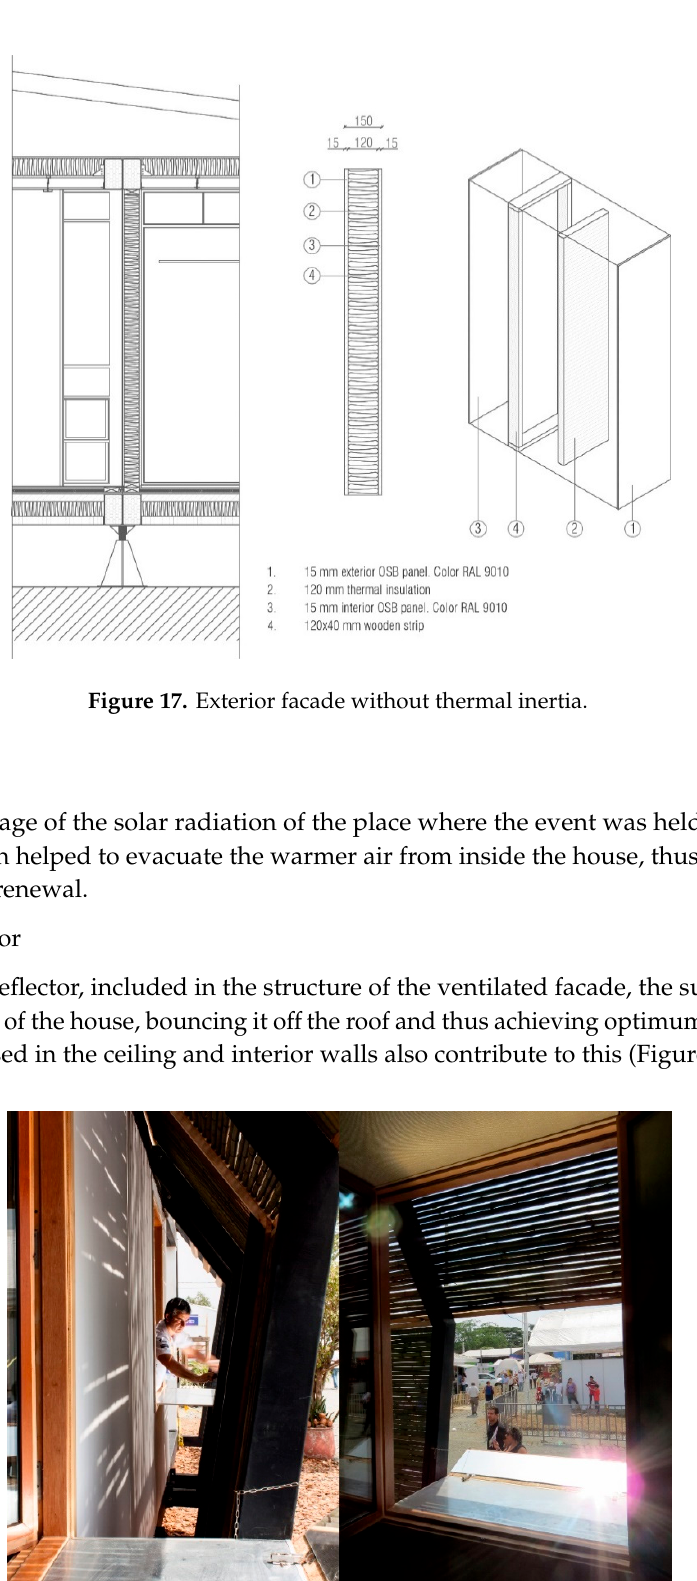
Figure 19. Graph of results by teams of the “Comfort Conditions” test. To evaluate the comfort conditions in each prototype, the judges installed several Printed Circuit Boards (PCB) in different rooms of each prototype (Figure 20). Those PCB contained the components to obtain the temperature, relative humidity, and lighting data. Each prototype that participated in the competition was monitored uninterruptedly for 10 days [44,45], 2 sensors were placed in each of them from which temperature data were obtained, 1 sensor where data was collected exclusively on relative humidity, and 1 sensor that provided the levels of natural lighting inside the house.